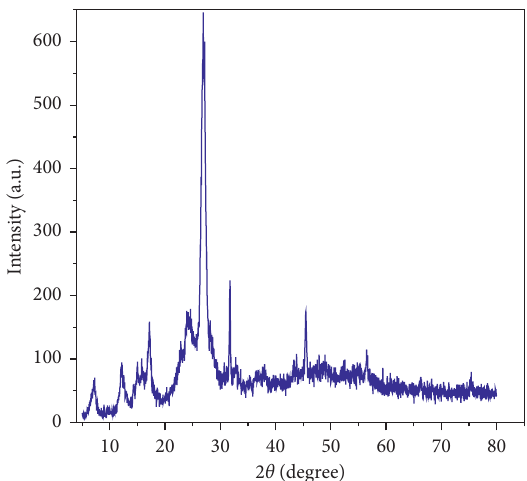
Figure 3: XRD spectrum of CPAT dye.